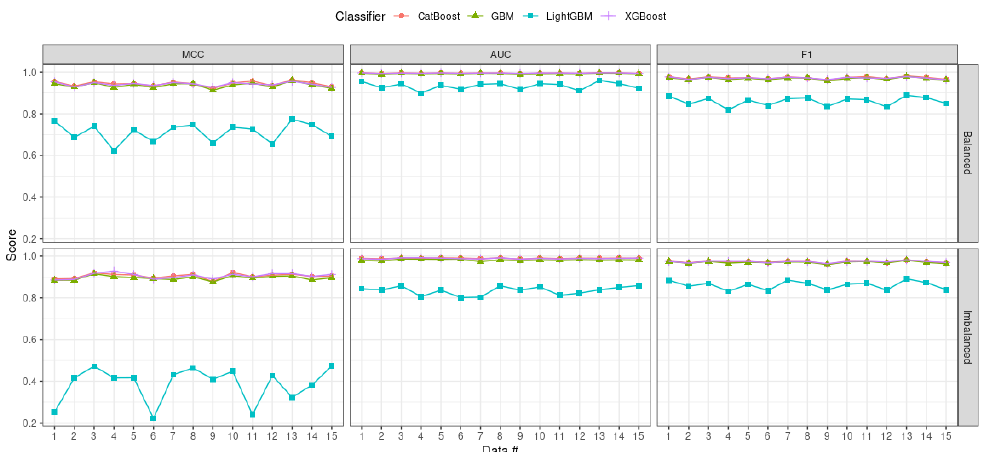
Figure 1. Average performance of all algorithms across various power system data sets.